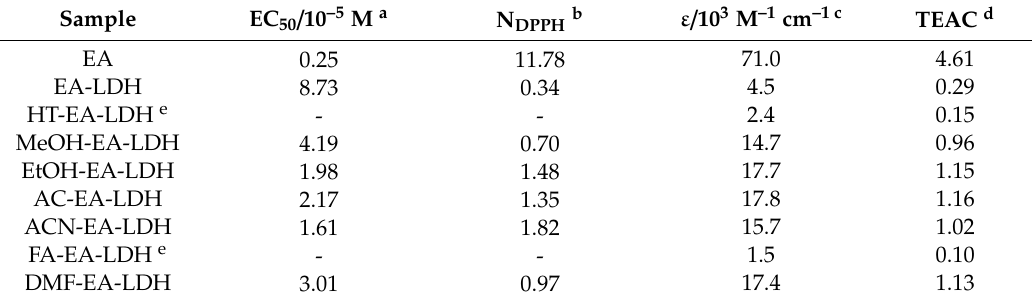
Table 1. Antioxidant activity values of the materials